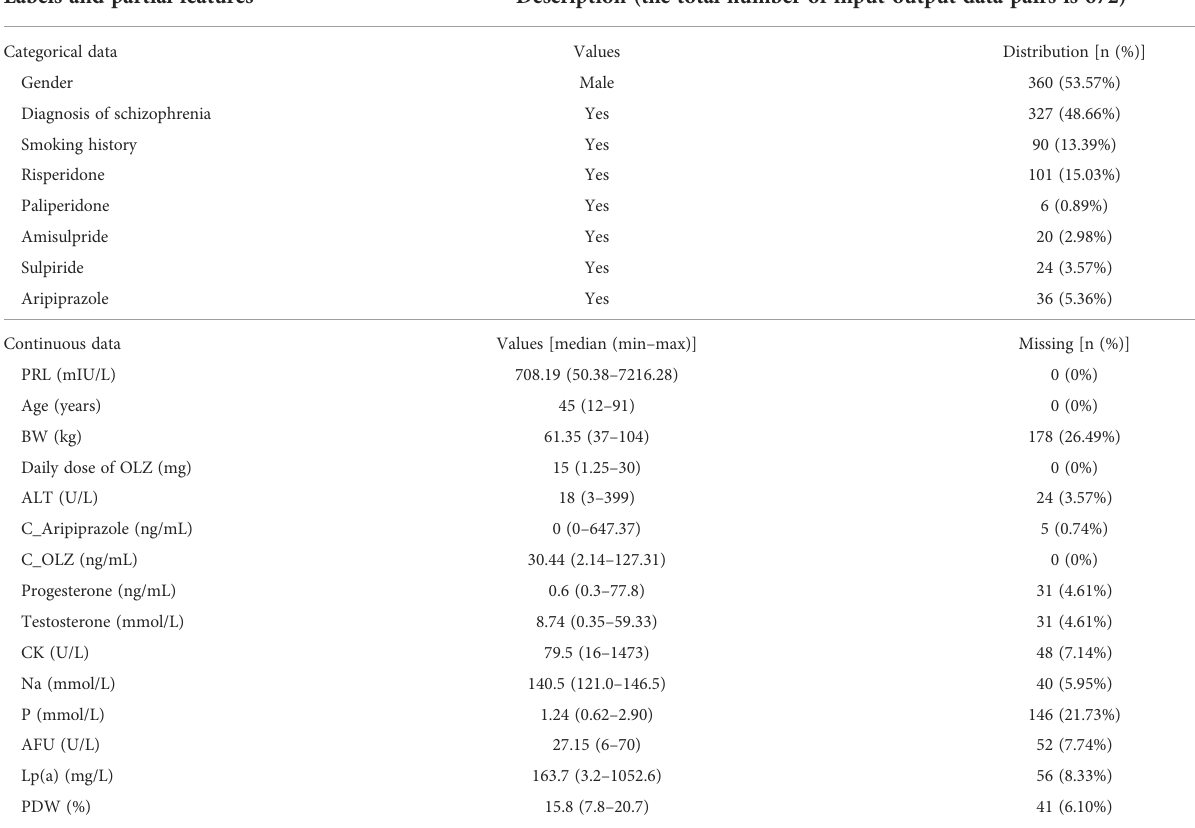
TABLE 2 The descriptions of labels and partial features before data preprocessing. Labels and partial